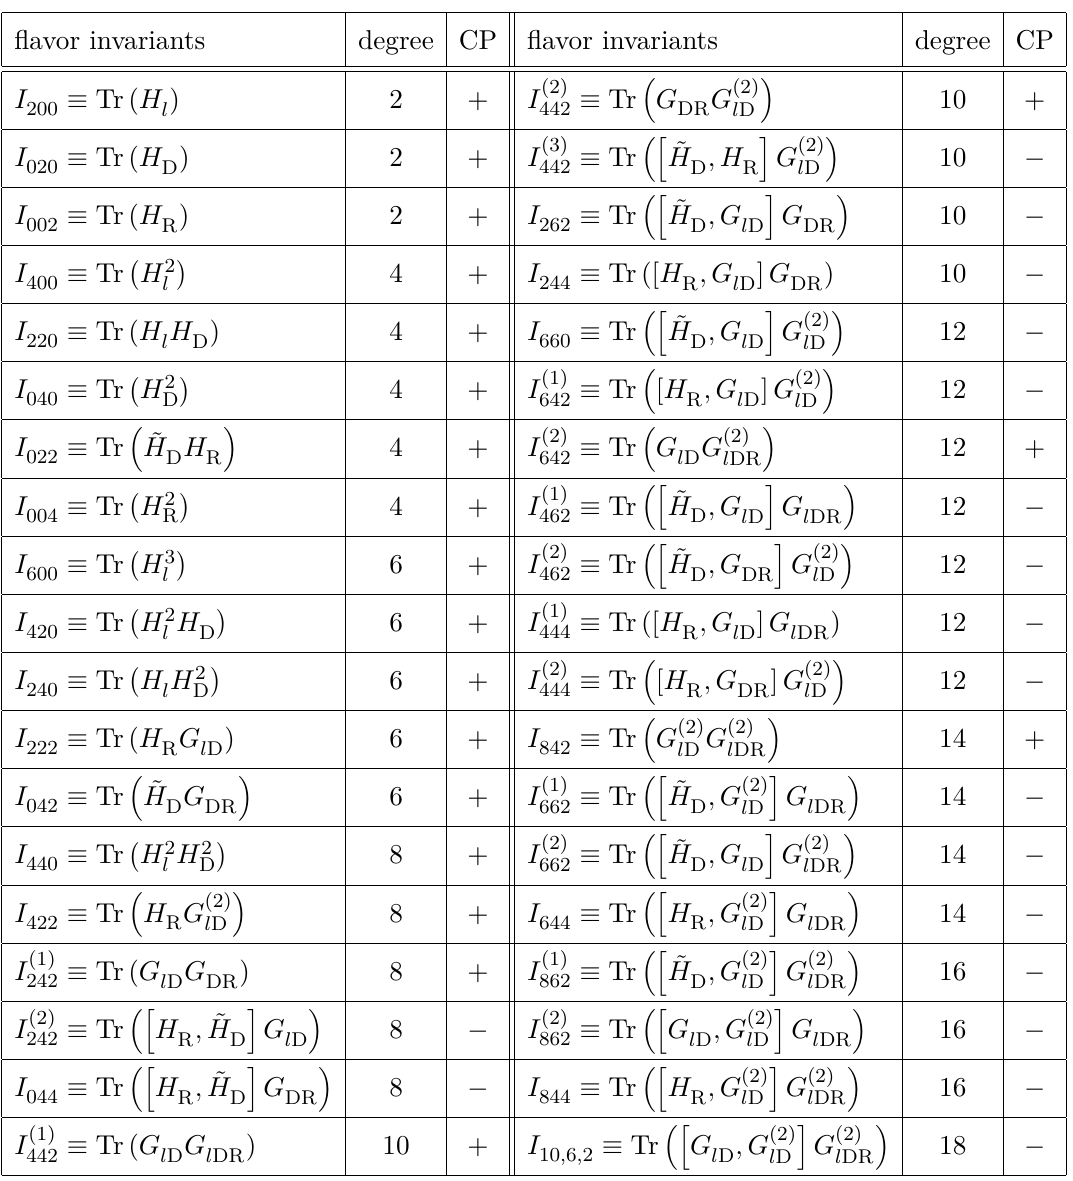
Table 2 . Summary of the basic flavor invariants in the generating set along with their degrees and CP parities in the MSM with two-generation RH neutrinos, where q degrees of M , M and M , respectively. Note that the commutator [ A, B ] ≡ AB − BA of two D R l matrices has been defined. To simplify the notations, we have also defined G